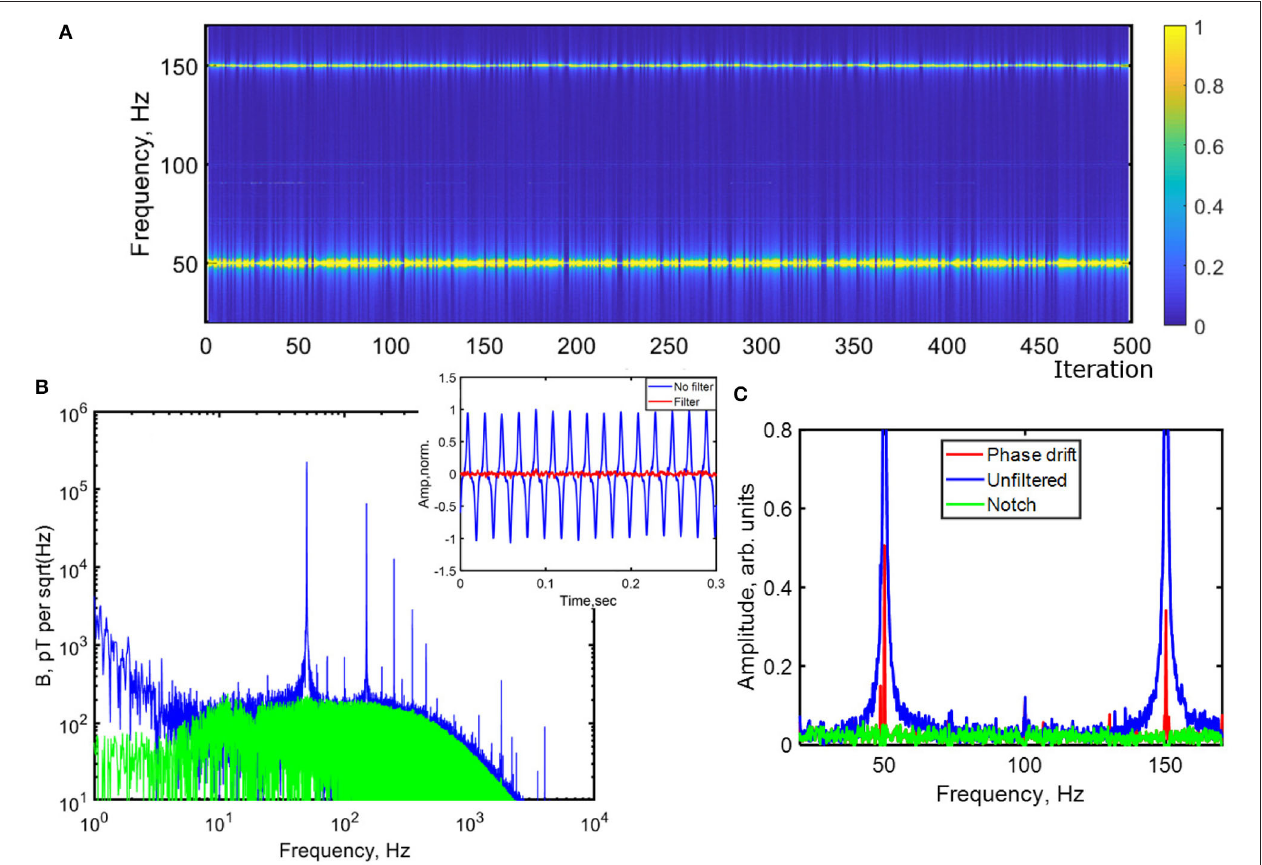
FIGURE 3 | (A) Normalized spectrogram of magnetometer pickup from 30 to 170 Hz from FFT of successive 60 s long measurements (iterations) at regular intervals over a period of 8 h. The variable phase drift during each measurement is seen as a broadening in frequency of the 50/150 Hz mains noise peaks. (B) Magnetometer sensitivity from a single 60 s measurement using 1 W pump power while magnetically sensitive before (blue) and after (green) filtering. The low frequency noise floor is 150–200 pT/ √ Hz , (inset) timeseries of signal before and after filtering, showing significant improvement obtained, (C) Single 60 s measurement before filtering (blue), ∼ after timeseries filtering (red) to remove phase drift and after notch filtering